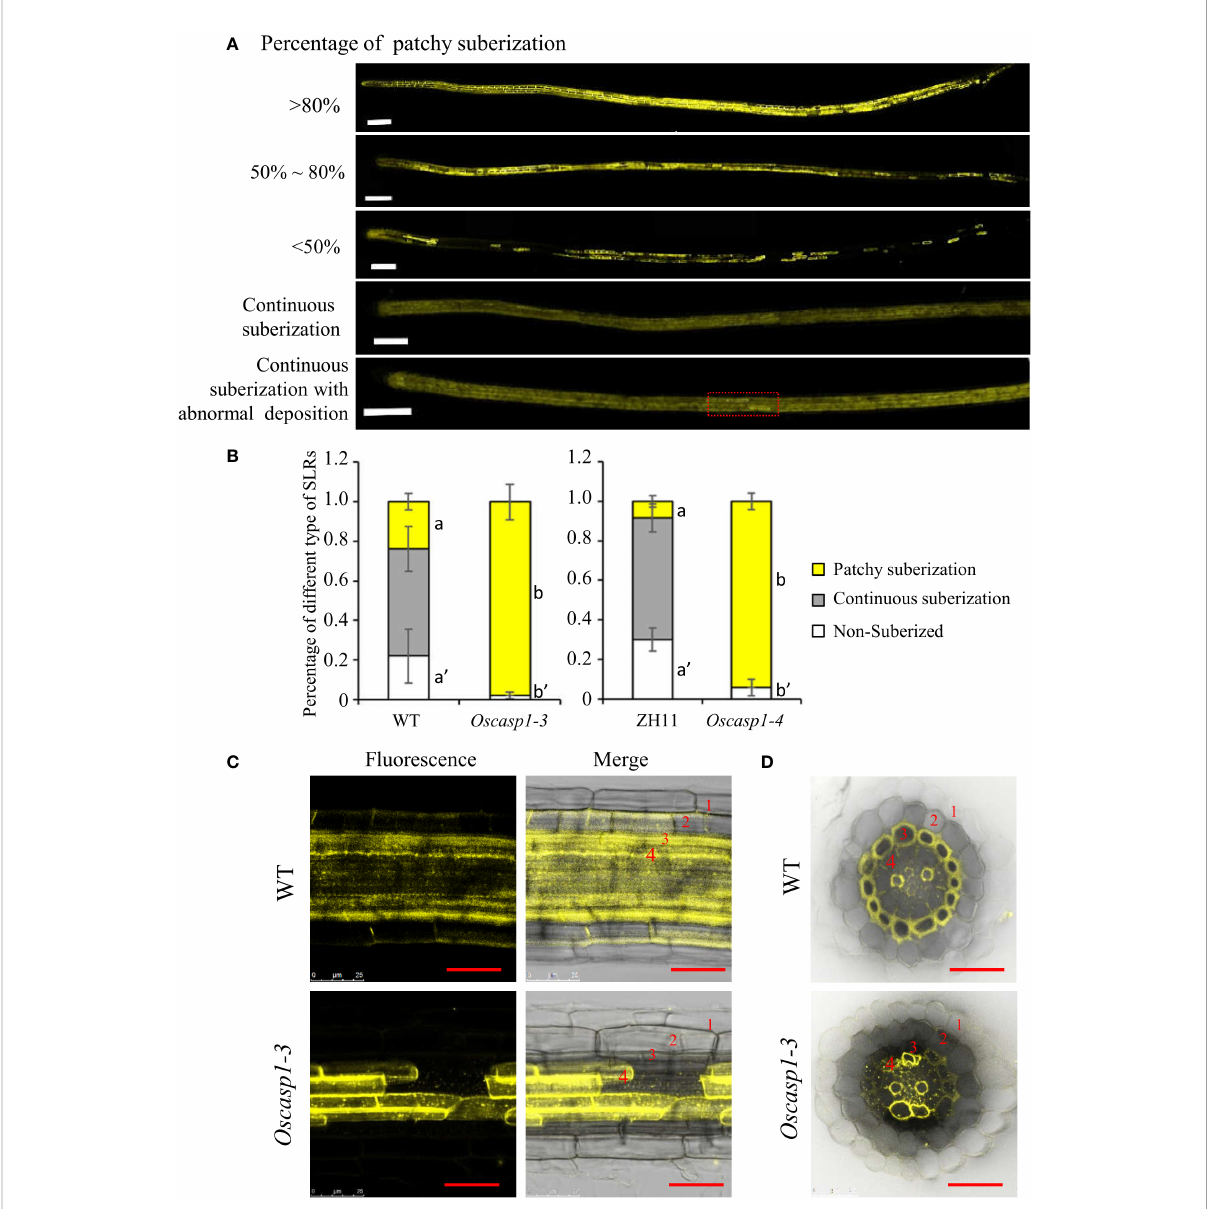
FIGURE 6 The patterns of suberin deposition of the small lateral roots. (A) The patterns of suberin deposition in small lateral roots of the WT and Oscasp1- 3 mutant, which were obtained with laser confocal microscopy. Scale bar = 100 m m. (B) The percentage of small lateral roots of each deposition pattern. Different letters denote signi fi cant differences in one-way ANOVA test (Tukey test p < 0.05) among different lines. (C) The representative pattern of suberin deposition in the WT and Oscasp1-3 . Scale bar = 25 m m. (D) Representative transverse sections from small lateral roots. Scale bar = 25 m m. 1, epidermis; 2, exodermis; 3, sclerenchyma; 4,